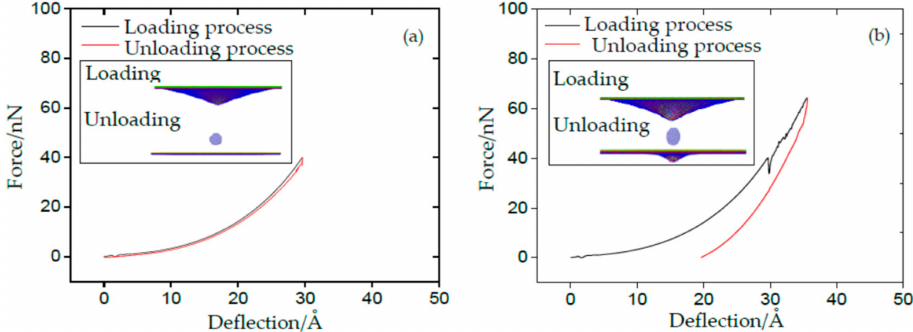
Figure 2. The force–deflection curves for the loading–unloading–reloading process of SLMoS2 nanosheets: ( a ) The deflection is smaller than δ a ; ( b ) The deflection is greater than the δ a but smaller than δ max .